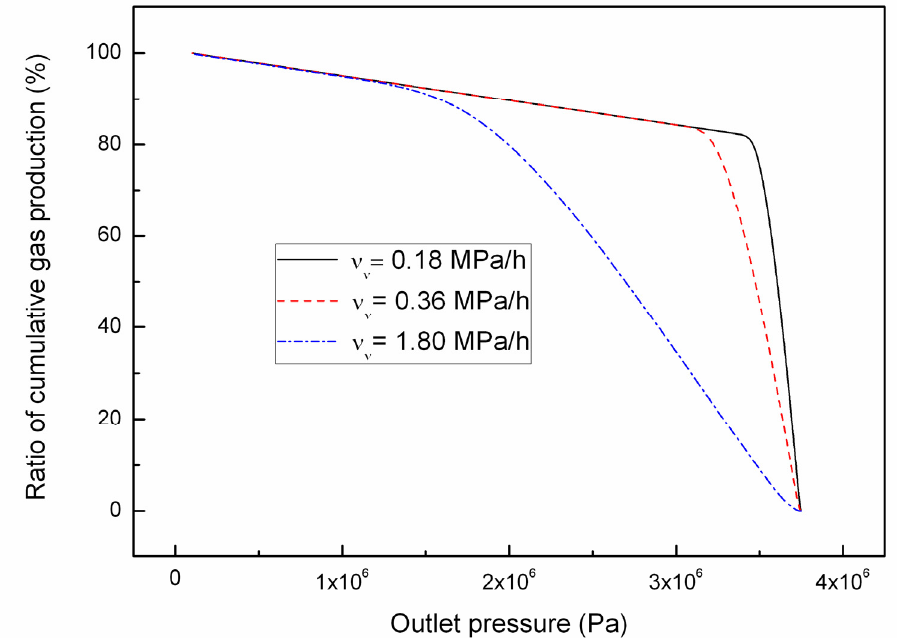
Figure 8. The relationships between the percentage of cumulative gas production and outlet pressure for different depressurizing